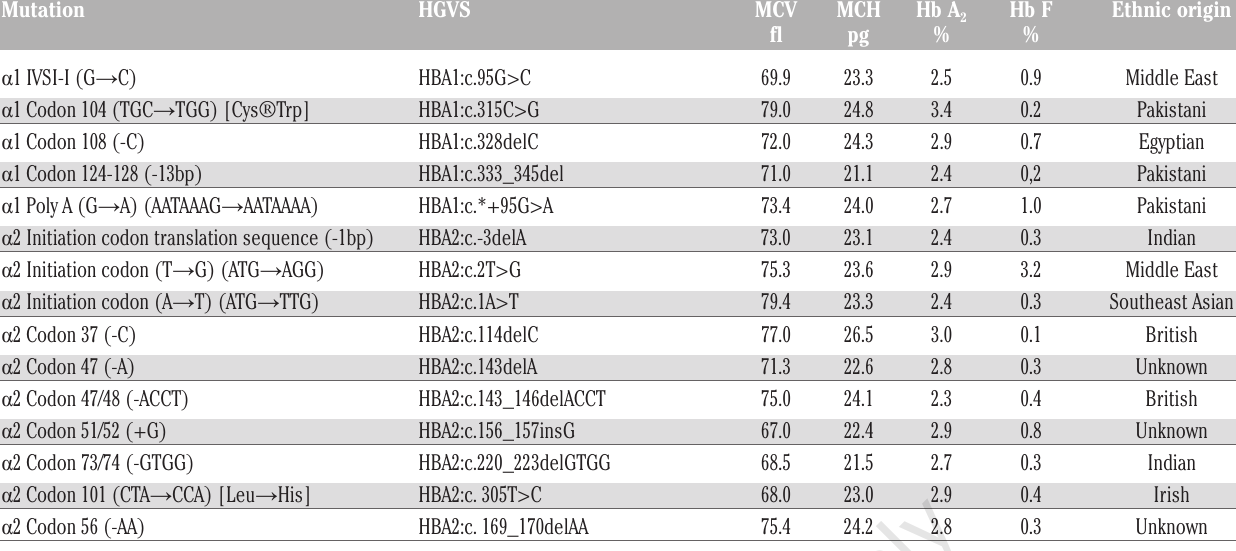
Table 2. Novel α + -thalassaemia mutations and some haematological findings. Mutation